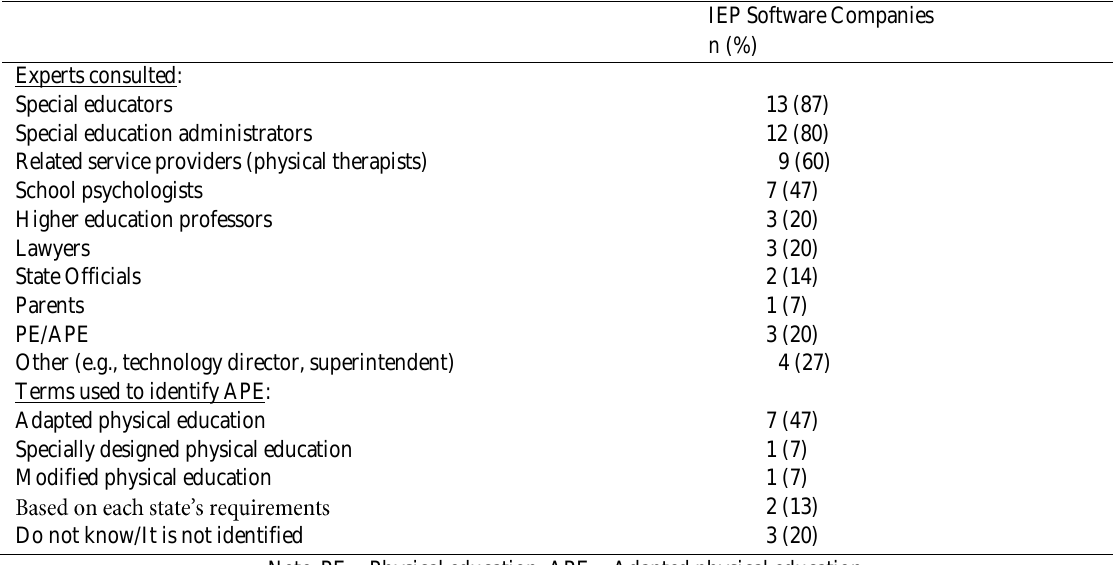
Table 4. How adapted physical education is reported.